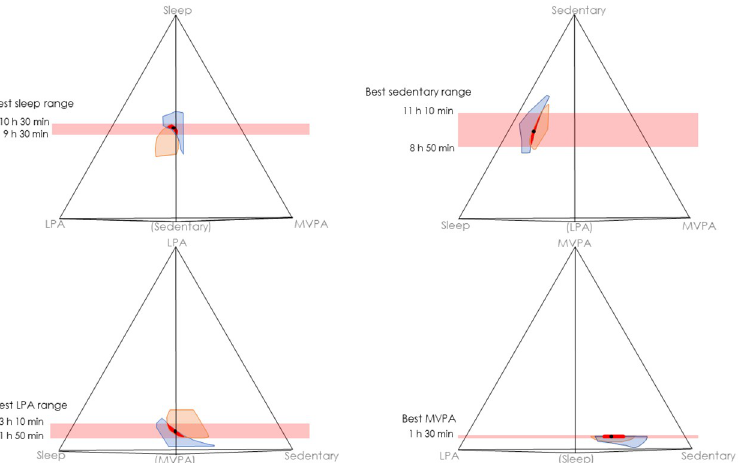
Fig 3. Estimated best zones for fitness (orange) and adiposity (blue) corresponding to time-use compositions associated with the best 15% of each outcome. Red denotes the best overall zone, where fitness and adiposity best zones overlap. Models adjusted for sex, age, puberty and household socioeconomic status. Fitness models additionally adjusted for body mass index z -score and included a quadratic term for the activity composition. The four plots show different rotations/perspectives of the same 3-D tetrahedron. Activities are at 100% (24 hours) at the corresponding apices of the tetrahedron, and 0% at the opposite base. A datapoint in the exact center of the tetrahedron would have equal shares of each activity (25%, or 6 hours). The activity in brackets is in the foreground. For an interactive 3-D plot, please see S3 File. The compositional mean of the overlap zone between the polygons (shown in red) is indicated by the black dot (h/day): Sleep = 10.2; Sedentary = 9.9; LPA = 2.4; MVPA = 1.5. LPA = light physical activity, MVPA = moderate-to-vigorous physical activity.